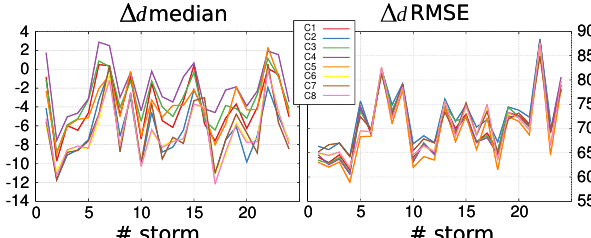
Figure 8. Performance metrics for wind direction for all storms. The left (right) panel shows the model performance evaluated using the median (RMSE) of (cid:49)d , as defined in the main